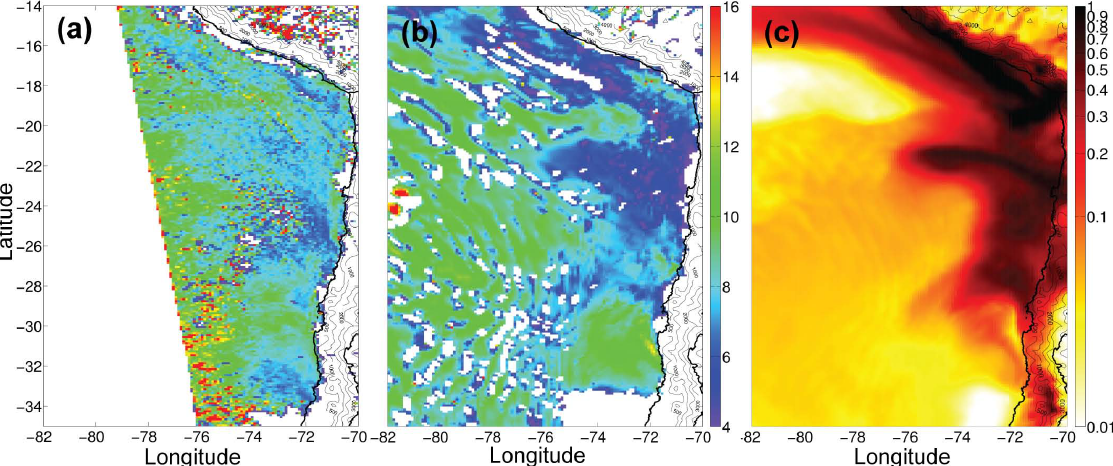
Fig. 10. Horizontal plots of cloud effective radius (µm, a and b ) and first level, second bin (78–156nm aerosol diameter) SO 4 concentration (µgm − 3 , c ). (a) shows MODIS-AQUA cloud effective radius for 16 October 17:00UTC overpass while (b) and (c) shows NW model results for the same time. Model cloud effective radius is computed for the cloud